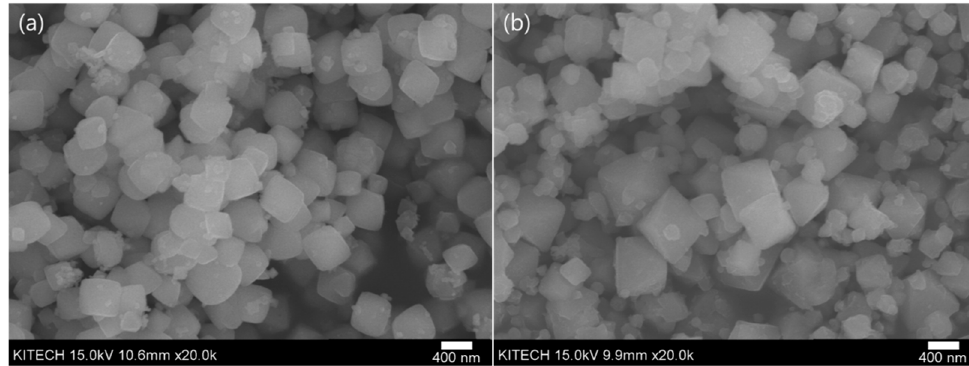
Figure 2. SEM images of Cu 2 O NPs ( a ) with NH 3 and ( b ) without NH 3.